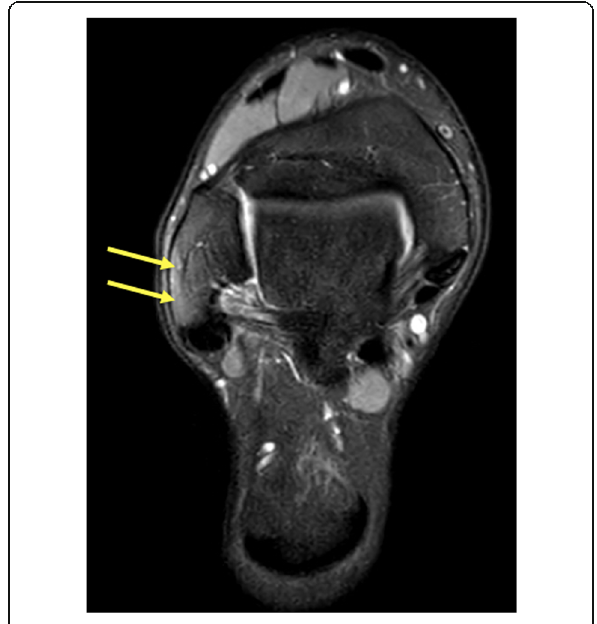
Fig. 35 An 18-year-old runner with Achilles tendon pain. MRI showed a typical artifact in the lateral malleolus on an FS sequence (arrows). There were no changes in the Achilles